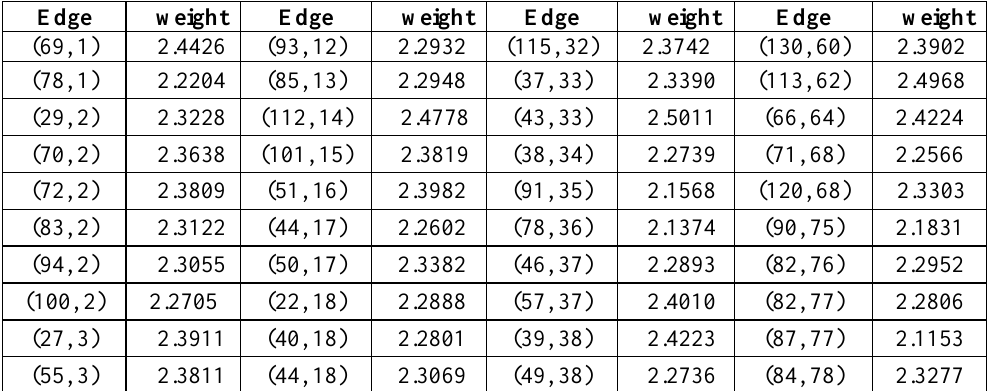
Table 1. Edges and their weights in the minimum spanning